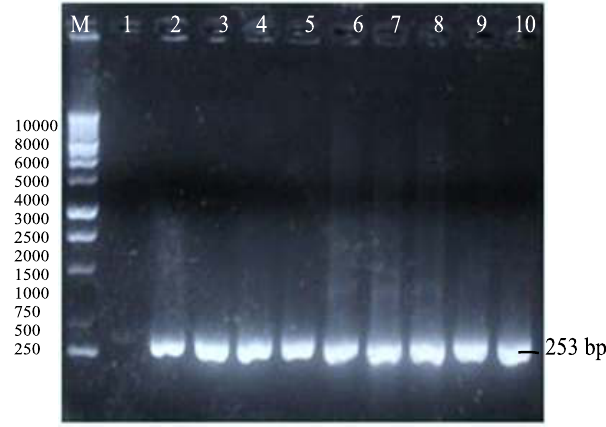
Figure-1. The pattern of antibody response to experimental B. melitensis infection in group A : 1, B : 2 and C : 3; in percentage of positivity